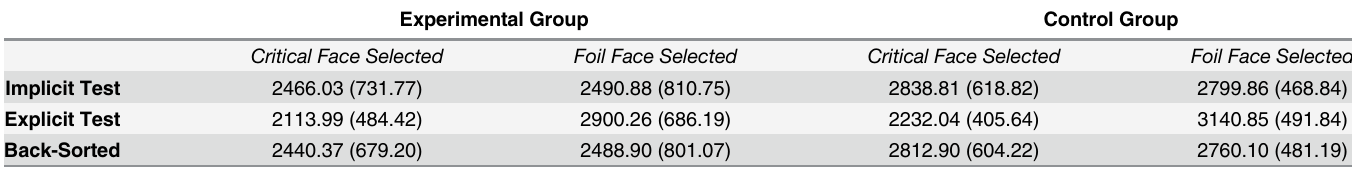
Table 1. Response Time (ms) Associated with Face Selection Following 3-Face Display Onset.